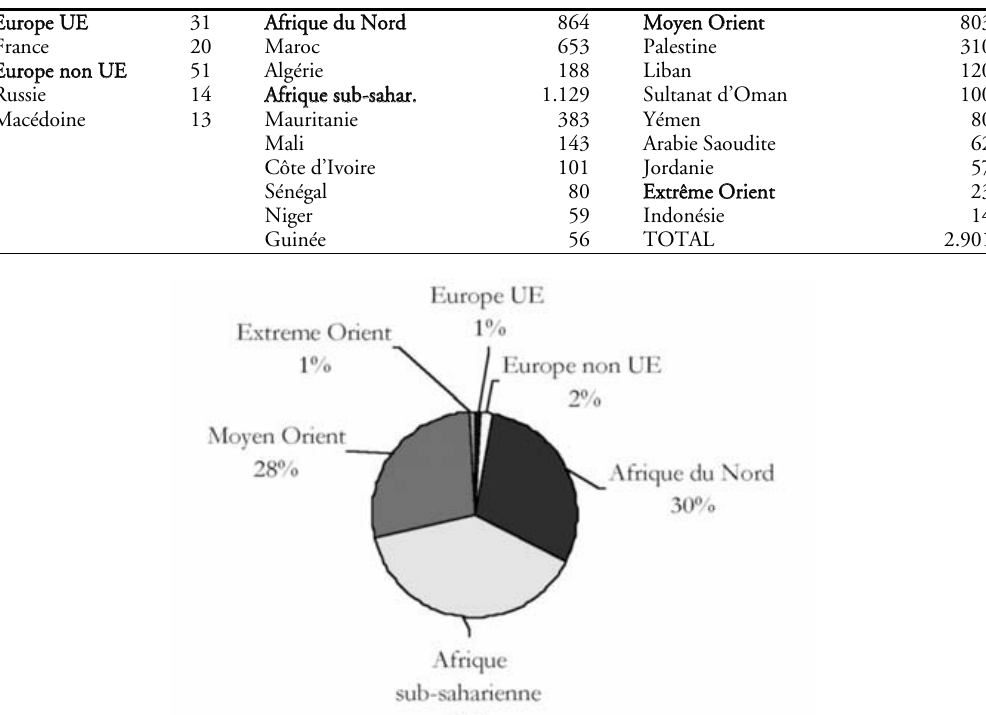
Etudiants universitaires étrangers en Tunisie (effectifs absolus), année universitaire 2001/2002 8 (Source: Association des Etudiants Africains en Tunisie, 2002) Europe UE